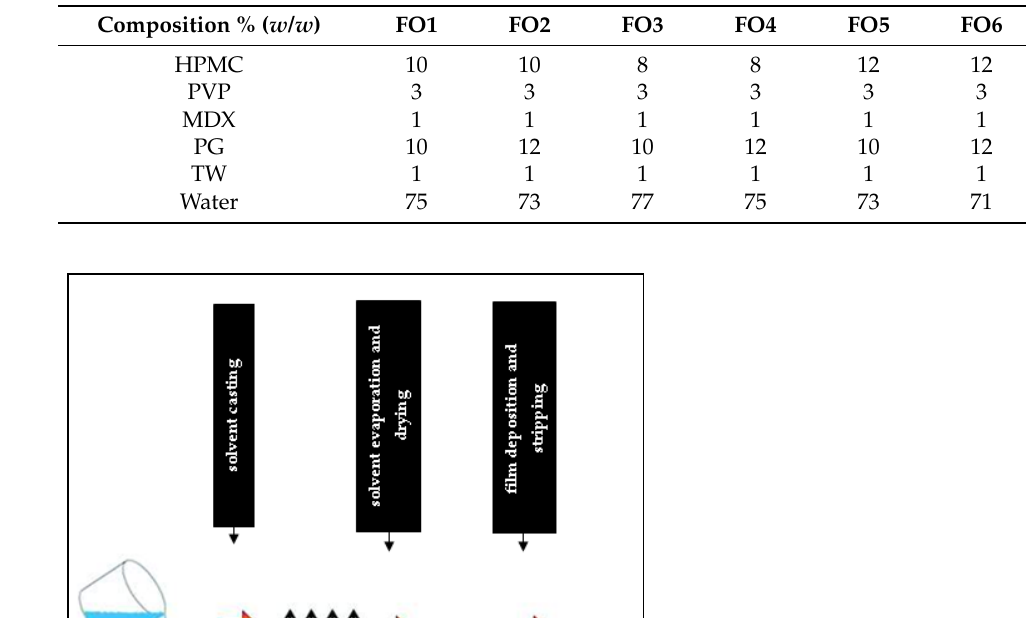
Table 1. Orodispersible films without FX.